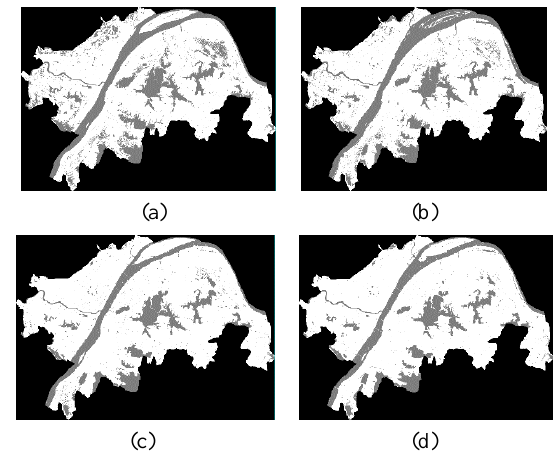
Figure 6. Binary maps of different MNDWI images based on OTSU segmentation: (a) 1991, (b) 2002, (c) 2011, and (d) 2017.